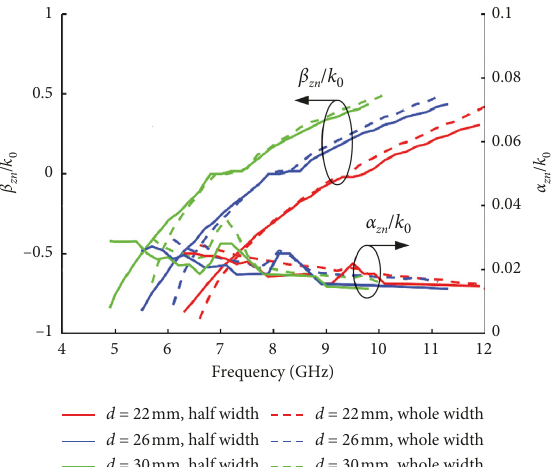
Figure 4: The propagation constants of the miniaturized and whole-width MLWA by HFSS .